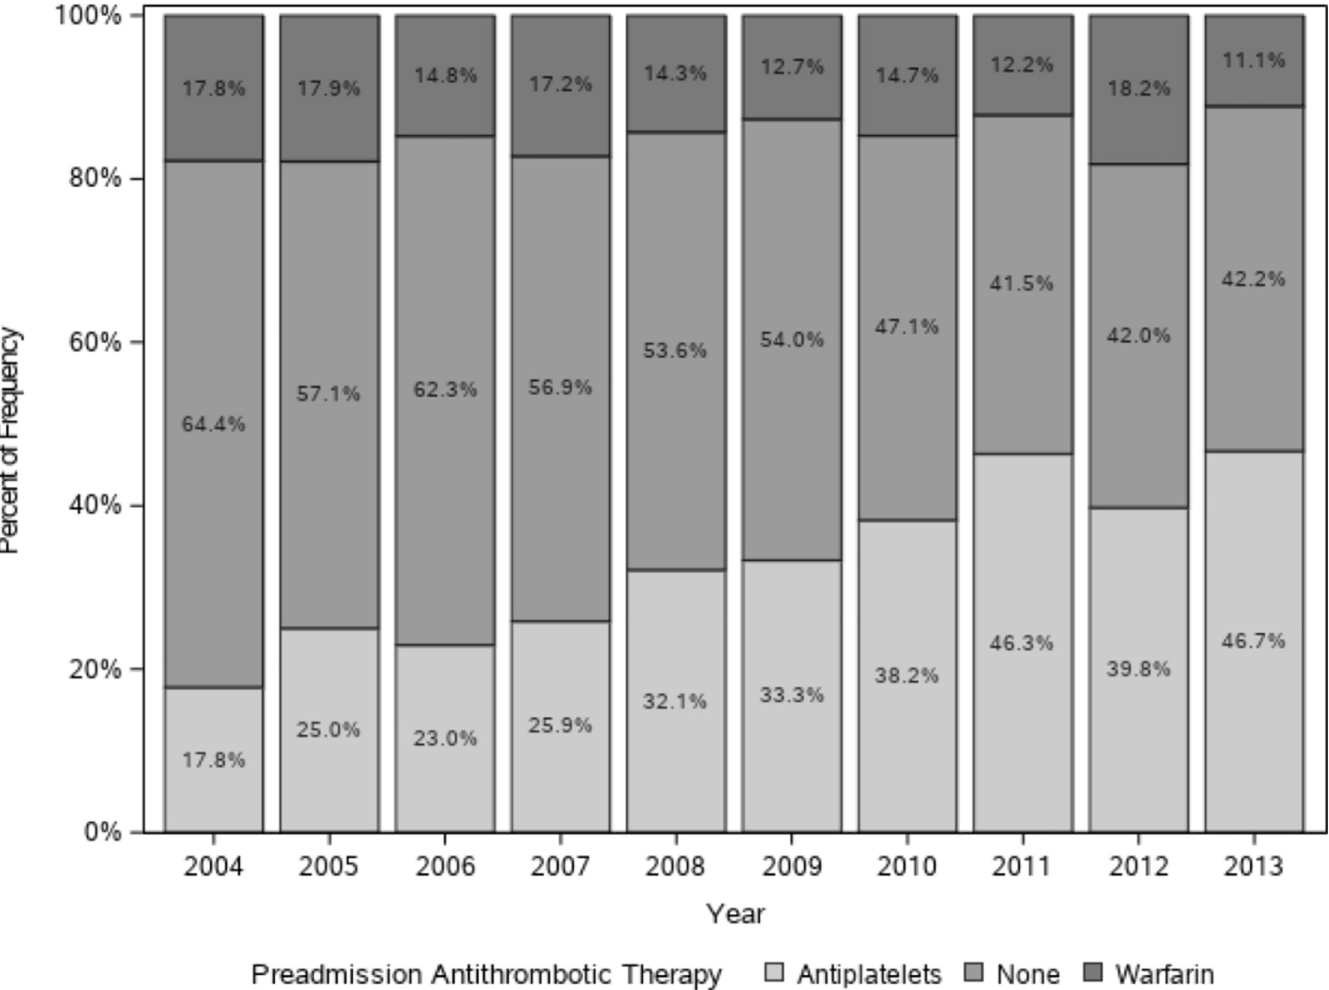
Fig 4. Preadmission antithrombotics therapy in OAC therapy candidates without high bleeding risk � . � CHA 2 DS 2 -VASc score � 2 and a lower bleeding risk (ATRIA score � 4) before acute ischemic stroke event were